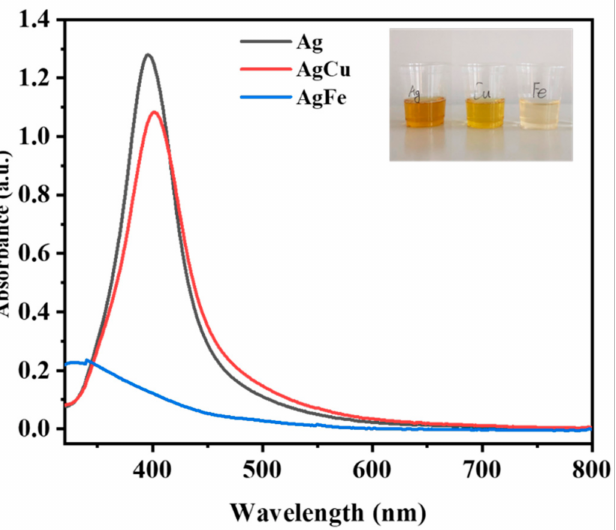
Figure 3. A comparison of the UV–visible spectra of Ag, AgCu and AgFe. The Ag concentration was 10 ppm for all samples and the Ag/M ratio was 2:1. The inset shows a color comparison of the AgNPs, AgCu NAs and AgFe NAs at the 10 ppm Ag